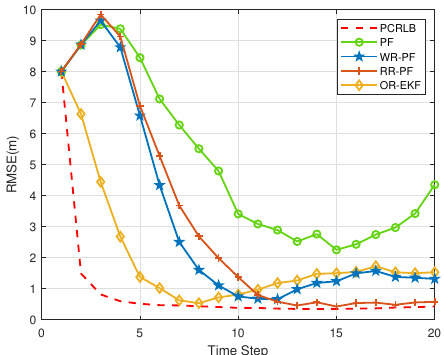
Figure 9. Bounds comparisons of estimated